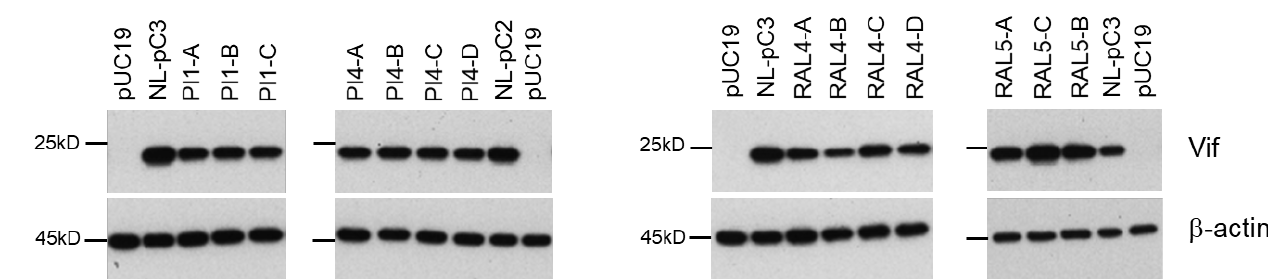
Figure 10. Vif expression levels of pro-viral clones carrying different SA1D2prox sequences in the HIV-1 NL4-3 genome. HEK 293T cells were transfected with the indicated pro-viral clones, and on day 1 post-transfection, cell lysates were prepared and subjected to Western blotting analysis using anti-Vif and anti- β -actin antibodies. Representative data from two independent experiments are shown.